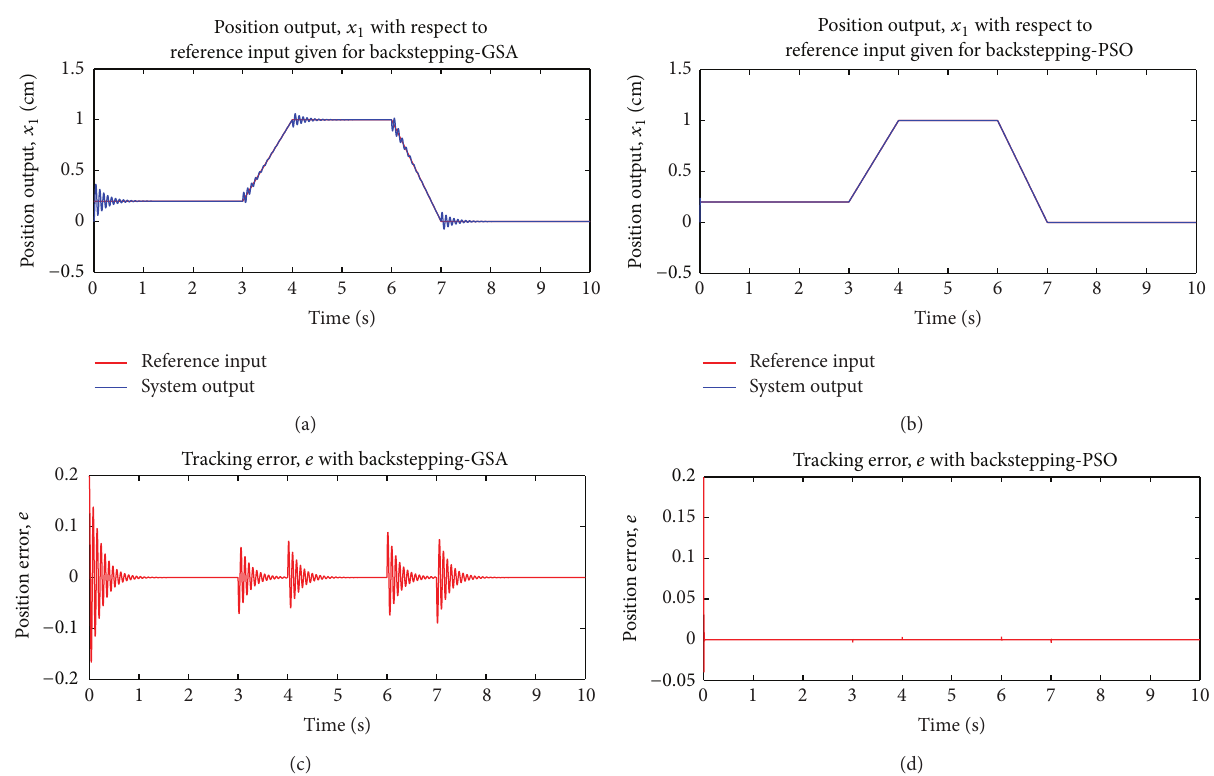
Figure 4: Position output with respect to reference input given and tracking error for backstepping-PSO and backstepping-GSA with time- varying